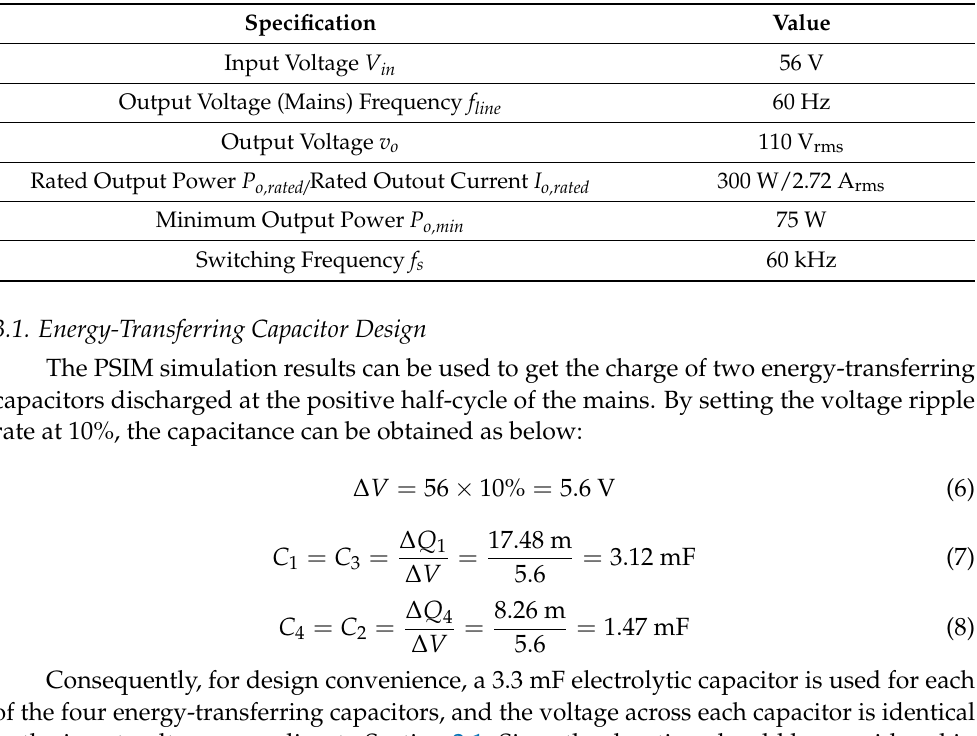
Table 3. Specifications for the proposed DC-AC